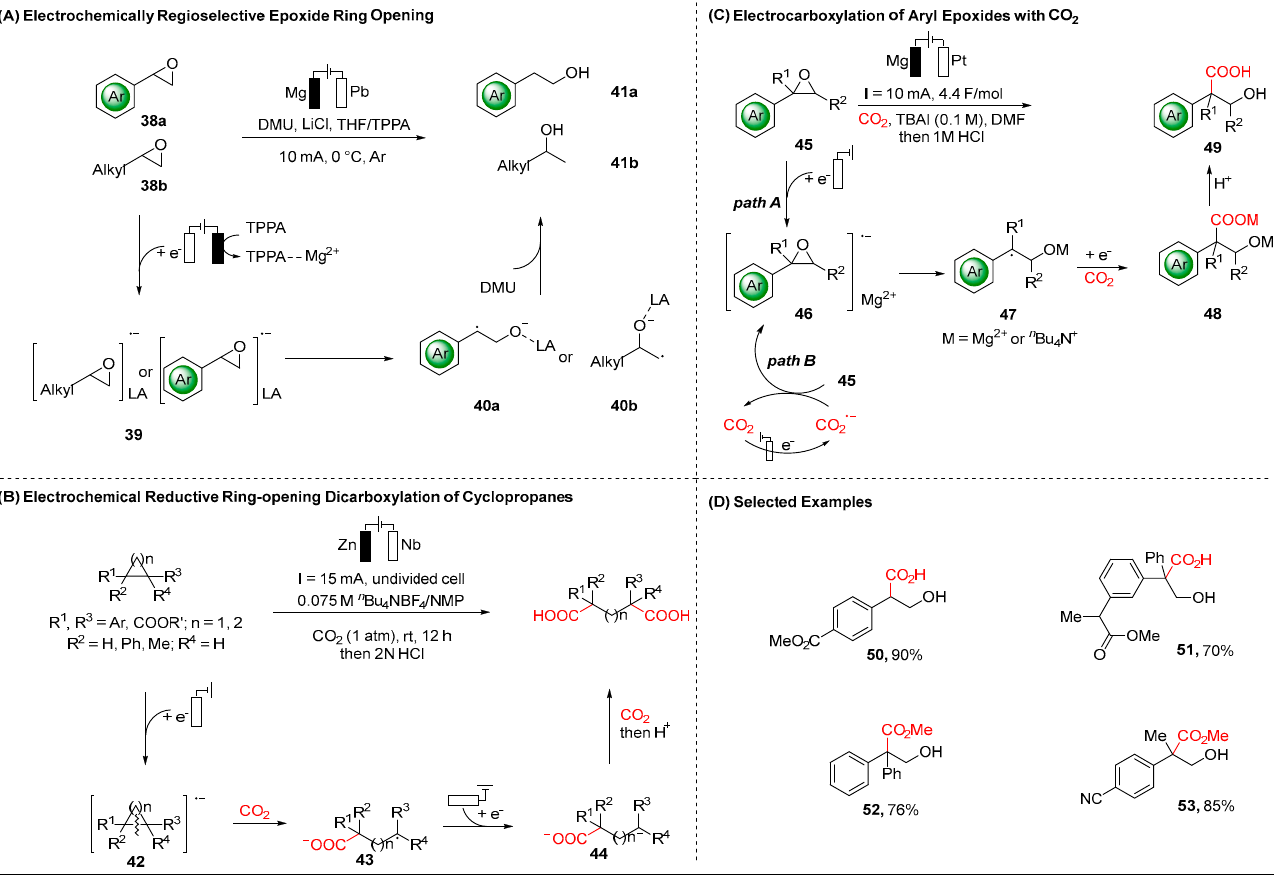
Figure 7. Electroreductionof epoxides or cyclopropanes.